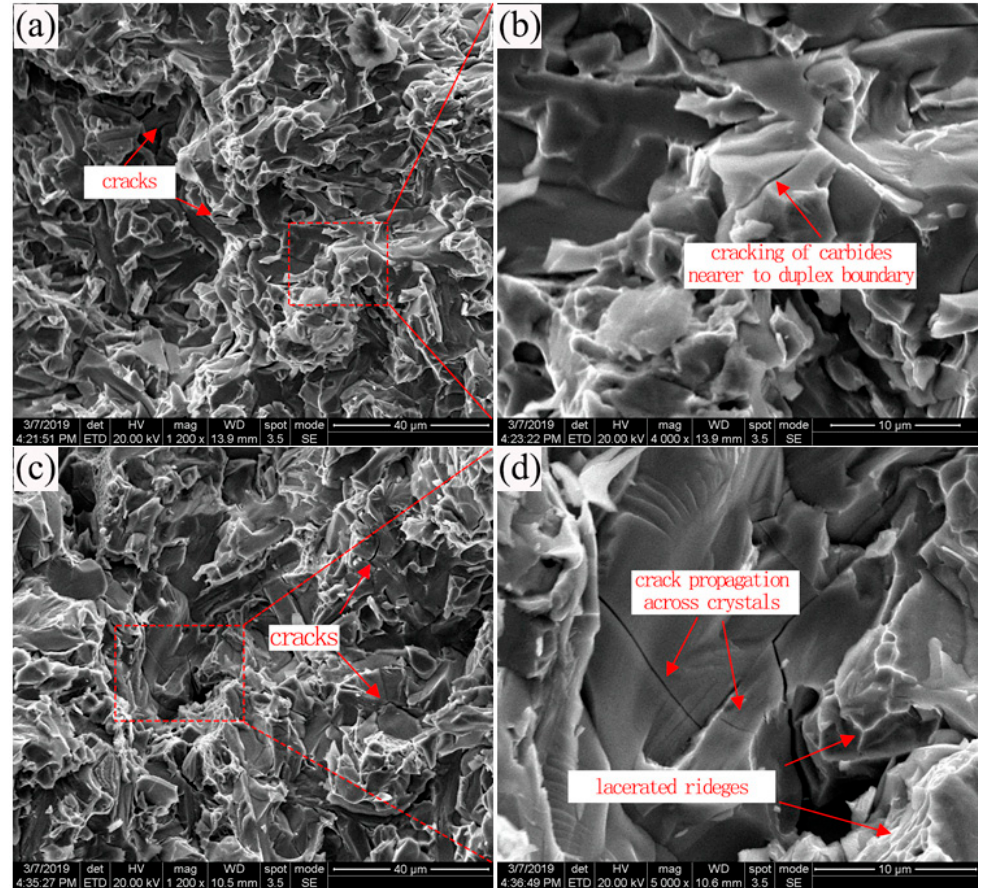
Figure 8. Fractograph of ( a , b ) specimen A, ( c , d ) specimen #4. Table 6. Statistical results of elements of EDS